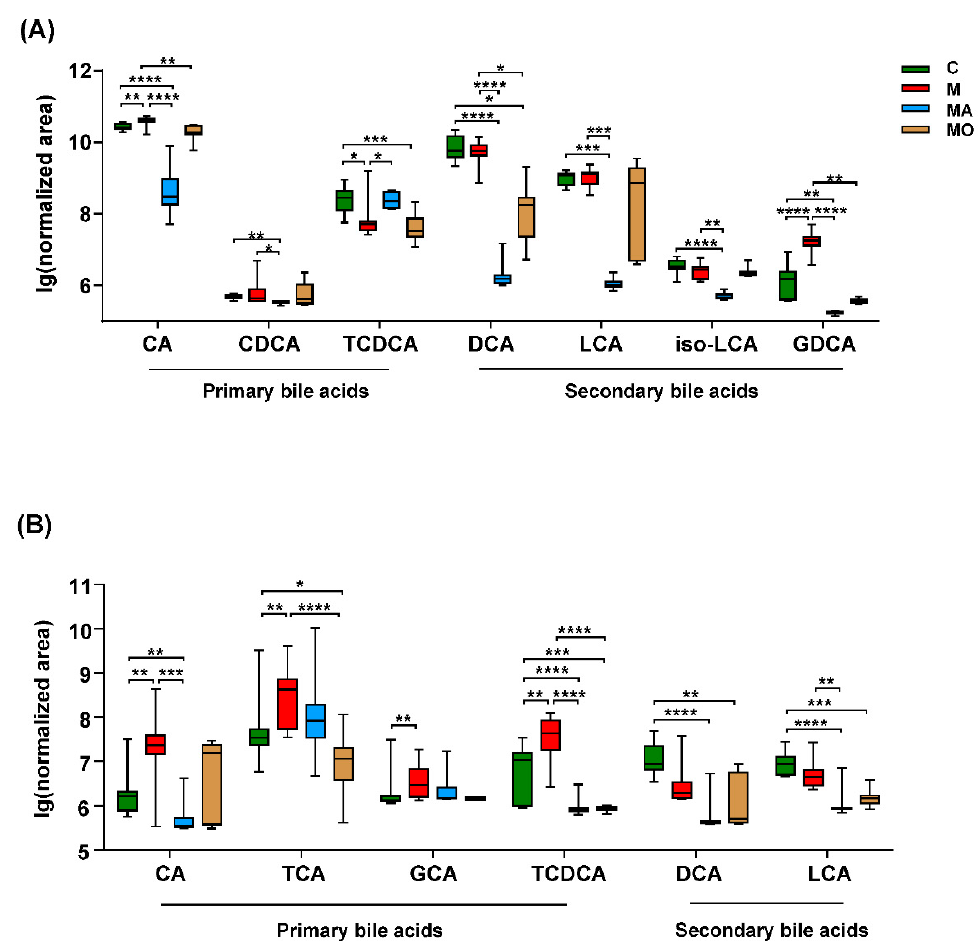
Figure 7. OCA supplementation modulated the gut microbiota-mediated bile acids disorders in HFHS diet mice. OCA supplementation decreased fecal, and serum BAs in HFHS diet mice and these BAs were also reduced by ABX supplementation. ( A ) Seven fecal BAs and ( B ) six serum BAs were detected in each of the mice. Note: data are given as medians with range. n : ( A , B ) 10–12 per group. * p < 0.05; ** p < 0.01; *** p < 0.001; **** p < 0.001. Groups: C, mice with normal chow;